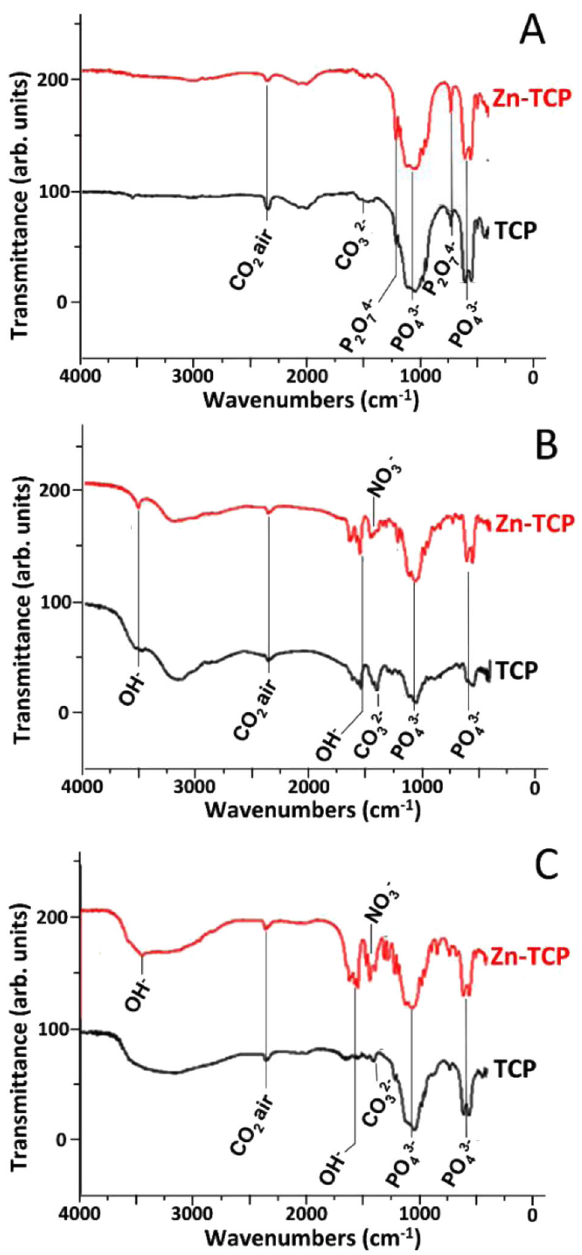
Fig. 2 FTIR spectra of: A non-substituted and Zn-substituted TCP powders, B non-substituted and Zn-substituted TCP cements, and C non-substituted and Zn-substituted TCP cements after soaking in physiological solution